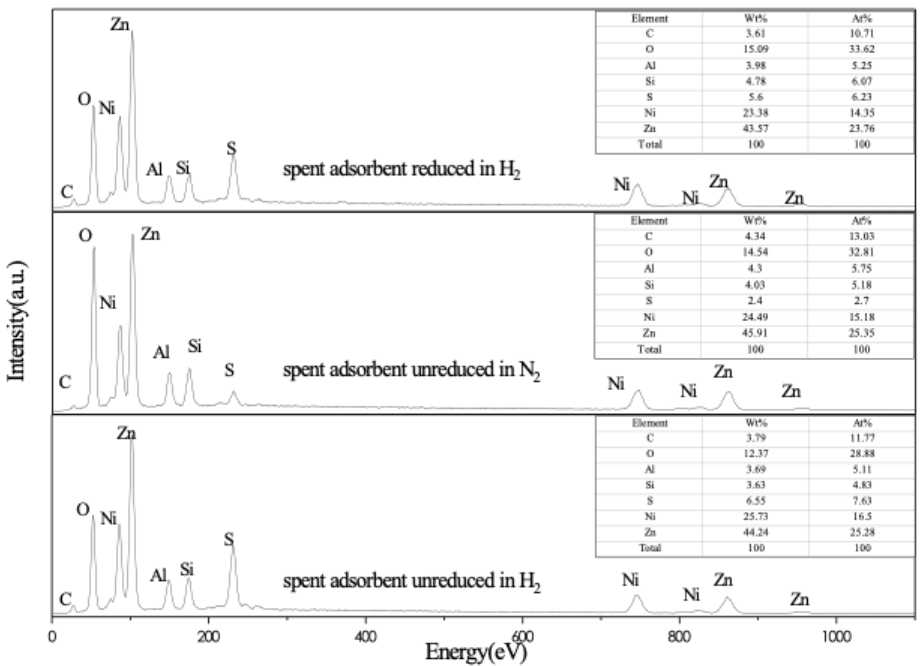
Figure 3. EDS analysis of surface element distributions of adsorbents before and after reaction.